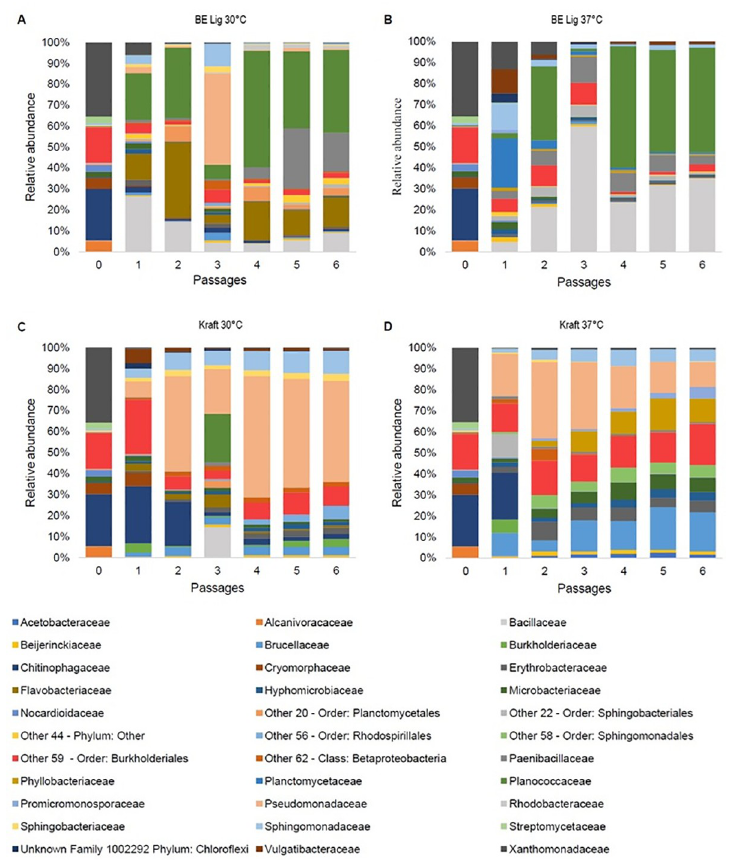
Fig 2. Family level taxonomic profile of bacteria at present in consortia obtained from MG soil over successive passages in enrichment experiment. M9 medium containing either base-extracted lignin, BE Lig, (panels A and B) or Kraft lignin (panels C and D) was initially inoculated with MG soil (MG) as the source of microorganisms. Experiments were performed at two temperatures. 30˚C (panels A and C) and 37˚C (panels B and D). Every 2 weeks an aliquot was transferred to fresh growth medium for enrichment in successive passages (0, 1, 2, 3, 4, 5 and 6). Bacterial families are depicted by different colors. For the families classified as Other and Unknown, we were unable to obtain the taxonomic affiliation at the family level, so the closest previous hierarchical level is